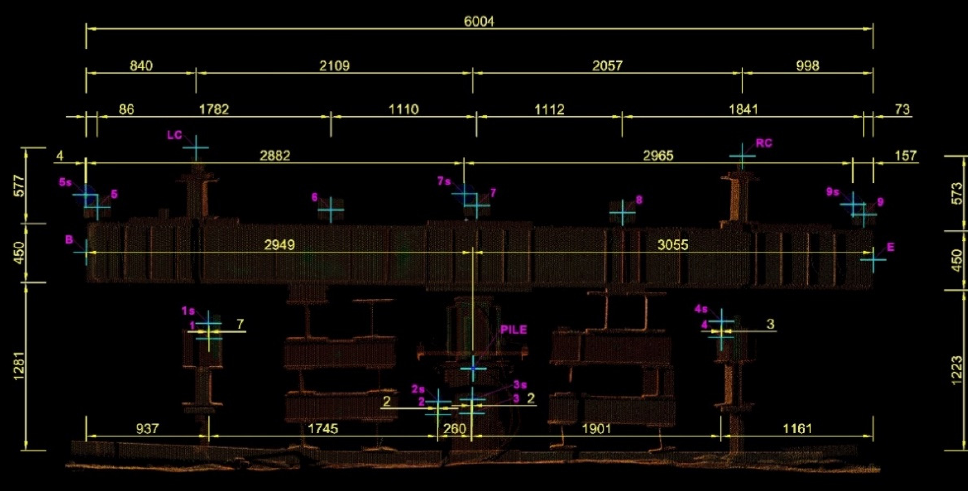
Figure 5. Scanned test stand: distances between structure elements and measurement points.